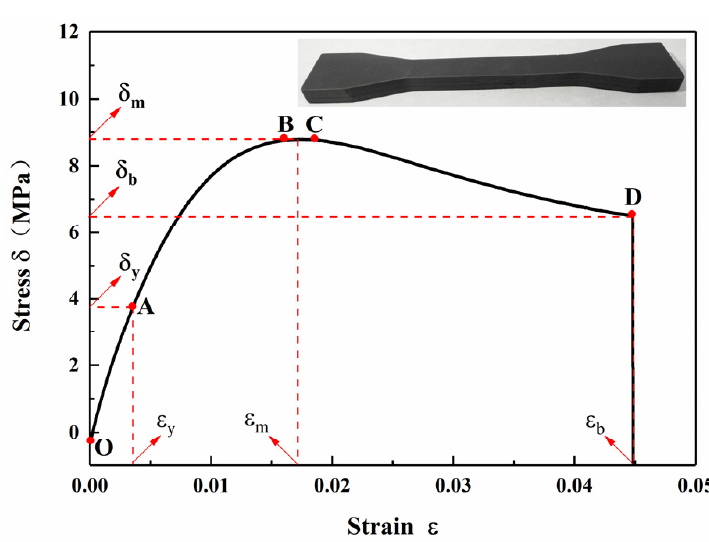
Figure 10. Compressive curve of a 3D-printed grain.